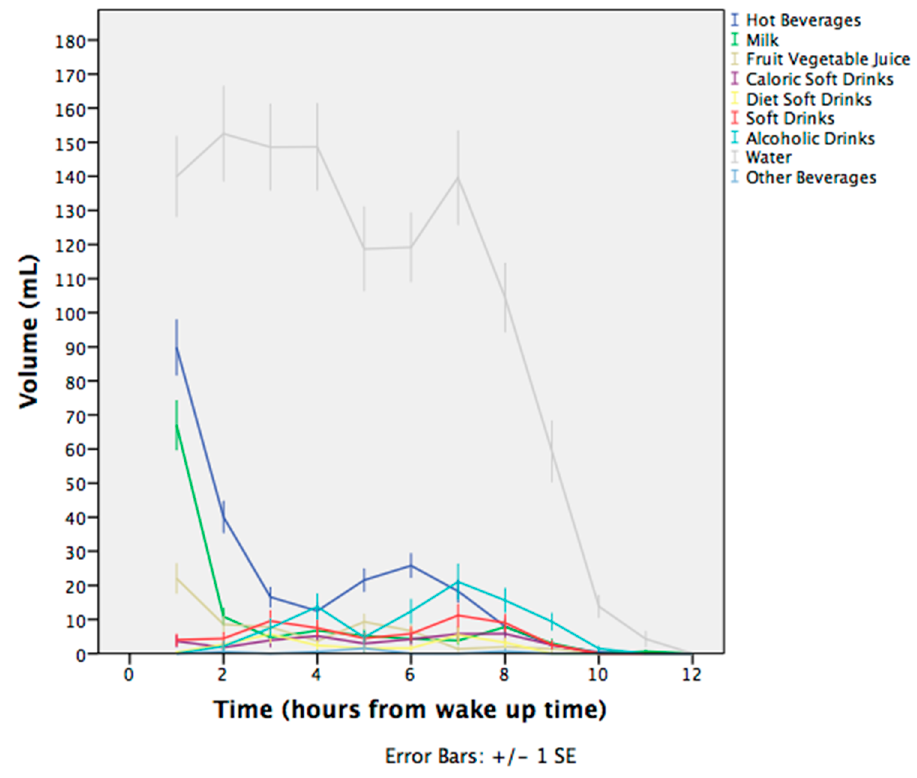
Figure 2. Volume of each category of beverage consumed during the Figure 2 . Volume of each category of beverage consumed during the day.